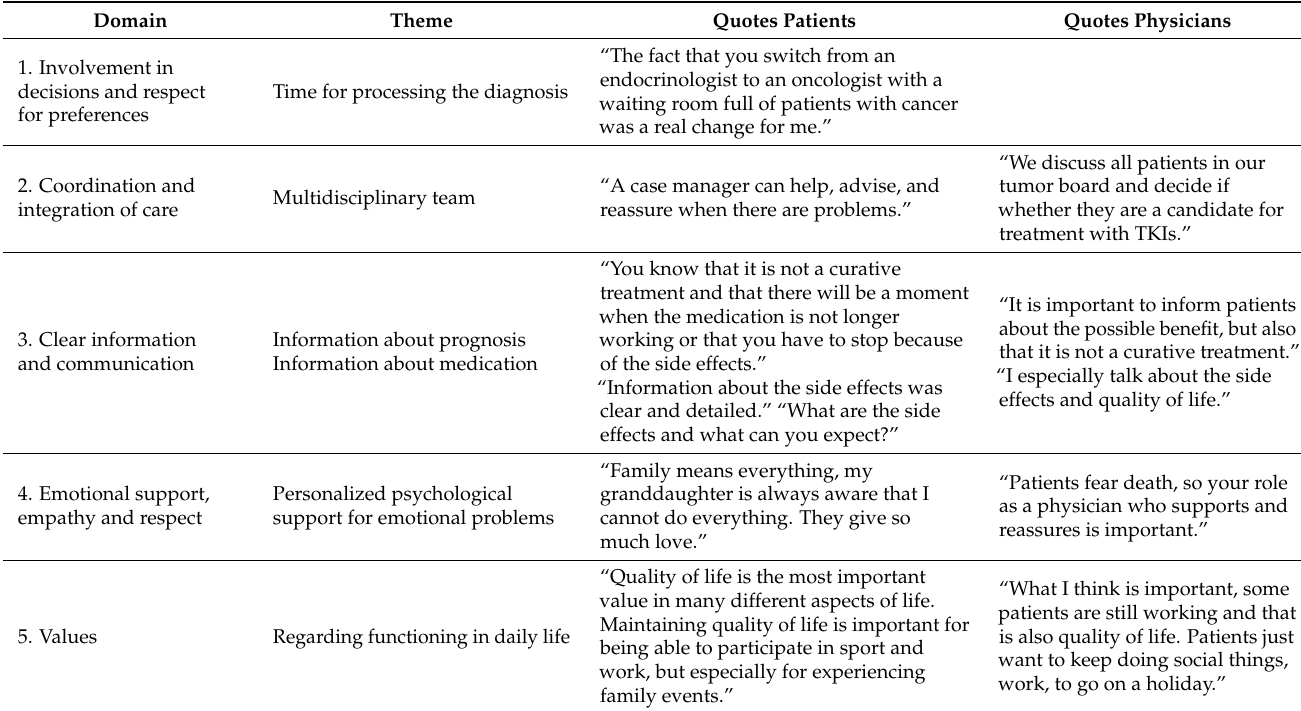
Table 5. Quotes of patients and physicians corresponding to some of the themes for the advanced disease decision regarding “wait or start with TKIs”.